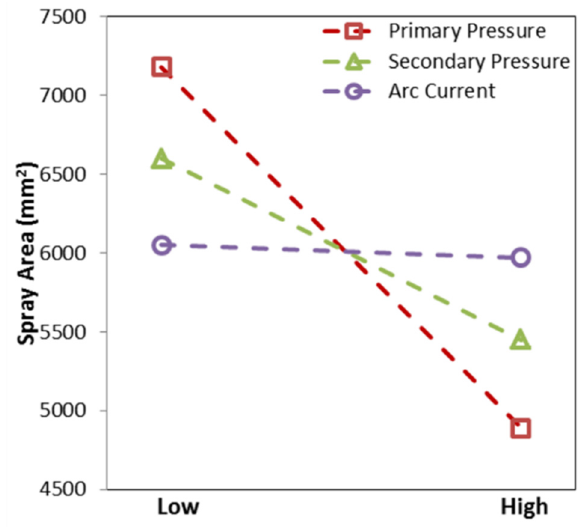
Figure 5. Effect of primary gas pressure, secondary gas pressure, and arc current on pattern spray area. Dashed lines not meant to imply a linear relationship.